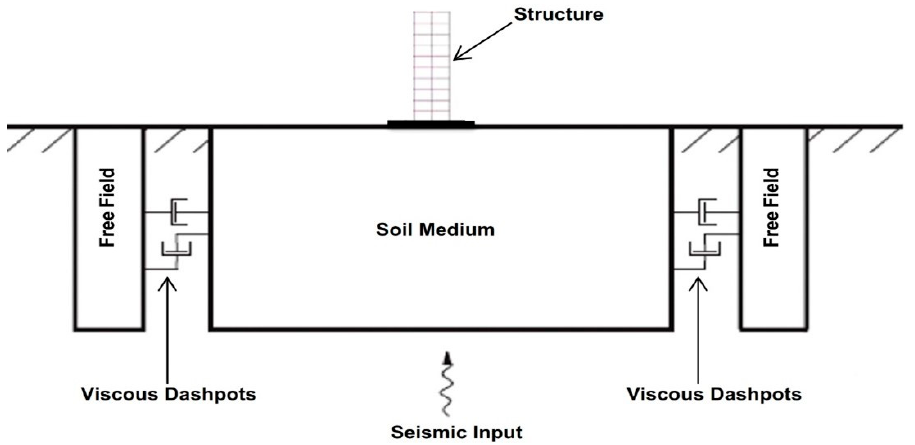
Figure 1. The modeling concept in the FLAC 2D program.